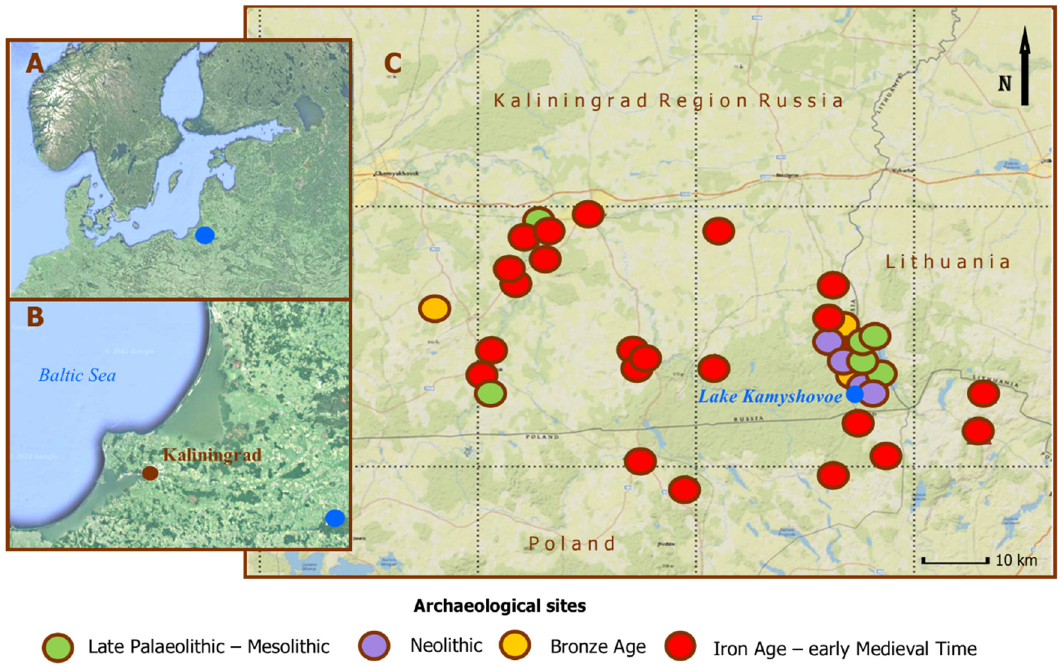
Figure 1. ( A )—Location of the studied site on the map of Europe. ( B )—Location of Kamyshovoe Lake in the Kaliningrad region. ( C )—Archaeological sites of different periods in the vicinity of the lake.